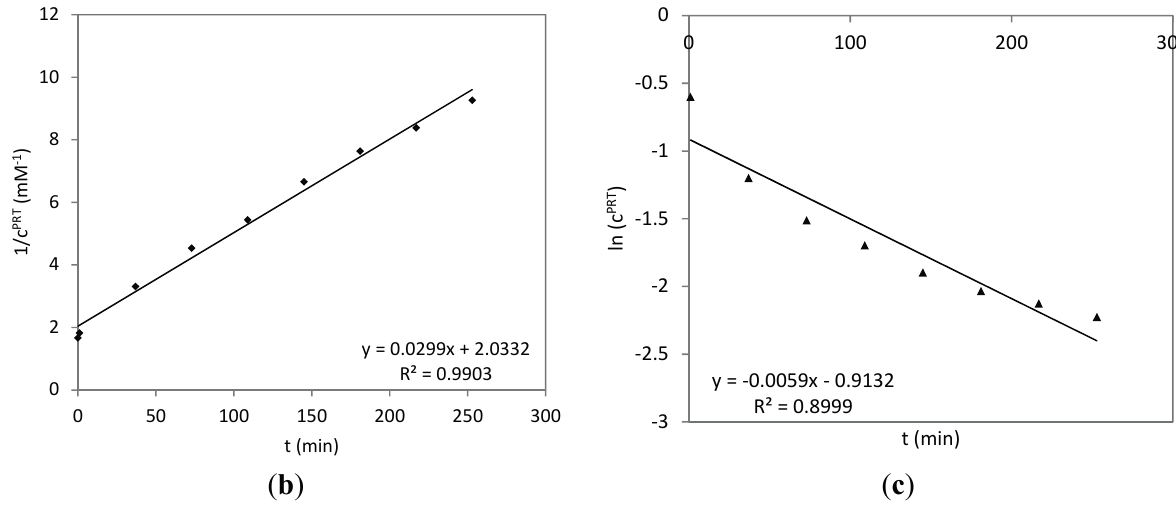
Figure 4. Time course of the reaction between HSA and PRT (filled circles) and for 11 β ,13-dihydroparthenolide (DHP, open circles); both sesquiterpene lactones (STLs) were incubated with HSA at an equimolar concentration (1:1, 0.6 mM). ( a ) The concentration of PRT and DHP vs. the reaction time; ( b ) linearization of the PRT time course according to the second order rate law; ( c ) linearization of the PRT time course according to the first order rate law. The reaction is more likely to proceed by second-order than by (pseudo) first-order kinetics, so that HSA can be assumed to represent one reactive site per molecule rather than multiple sites. From the data of DHP in (a), it becomes obvious that the α -methylene- γ -butyrolactone moiety is the only structure element in PRT responsible for the reaction with